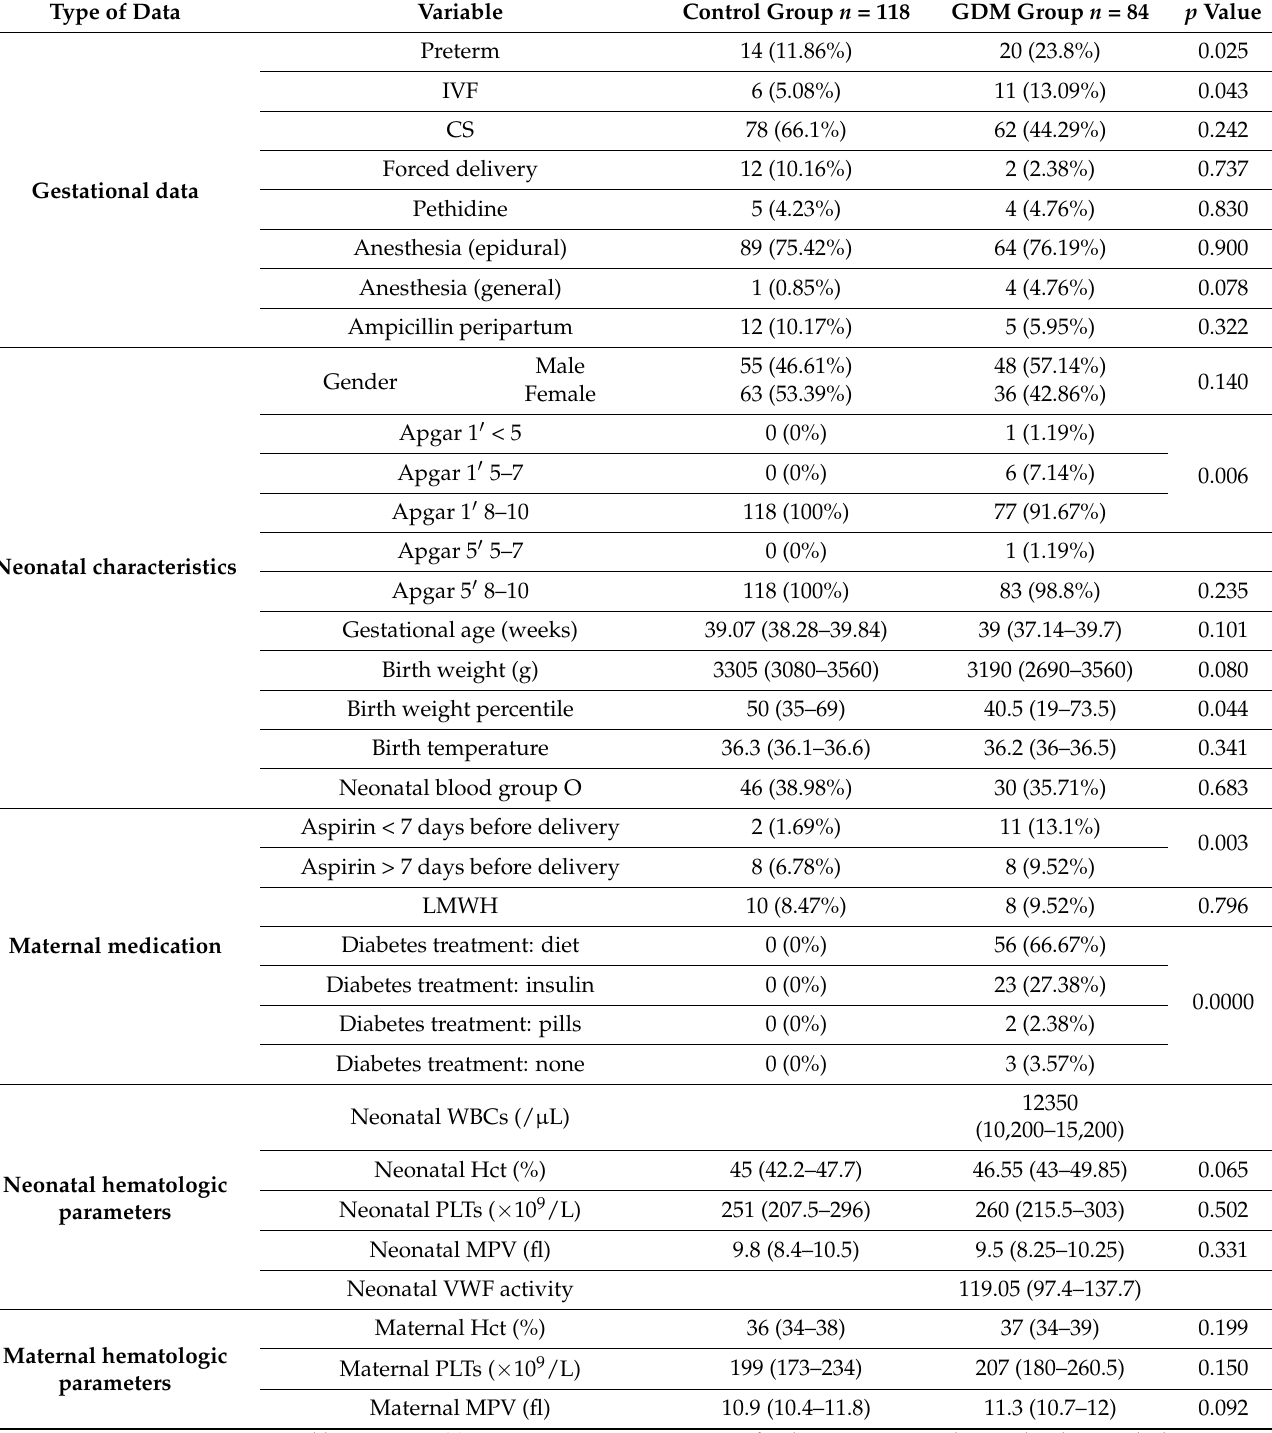
Table 1. Demographic and laboratory data of neonates born to mothers with GDM and control